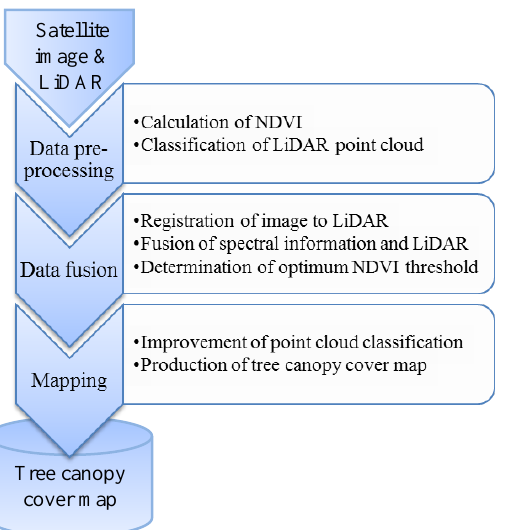
Figure 1. Flowchart of tree canopy cover mapping